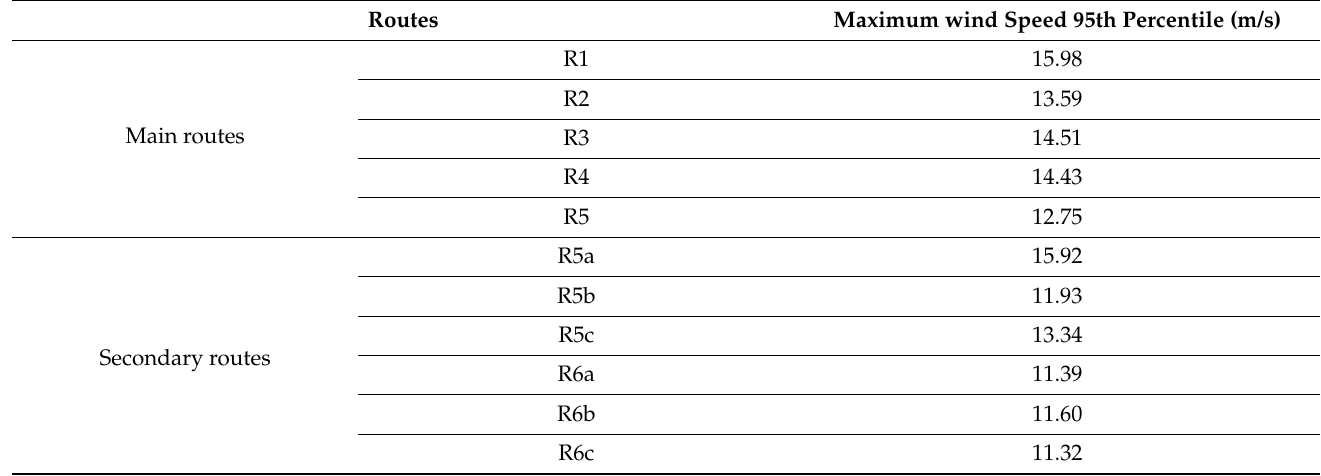
Table 3. Maximum wind speed 95th percentile on each route considered in this